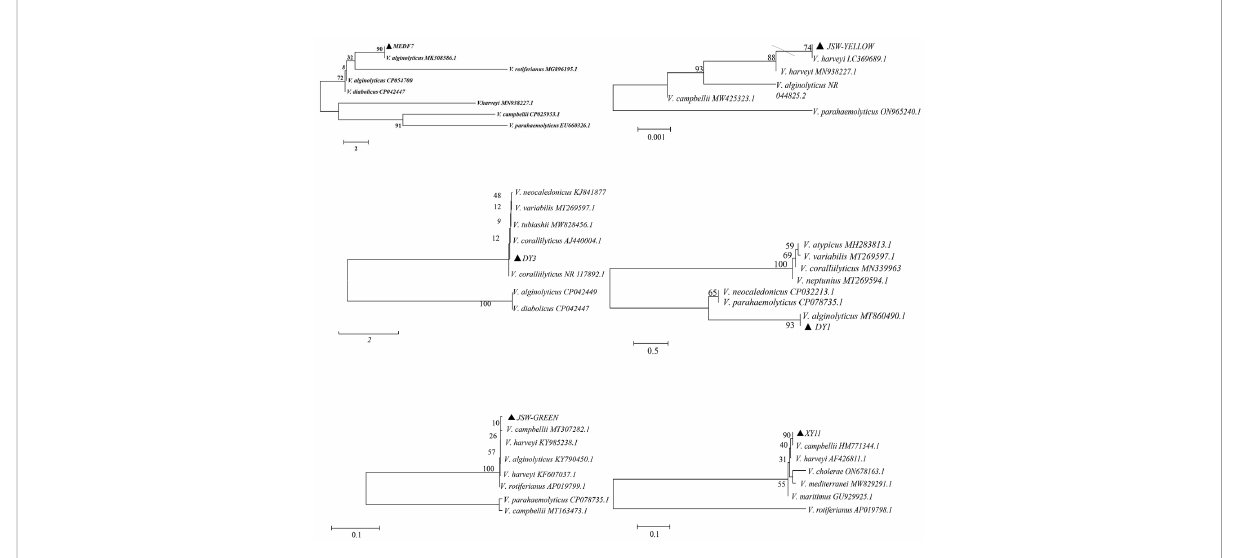
FIGURE 3 The 16S rRNA phylogenetic tree. Phylogenetic tree construction using MEGA6.0 and neighbor-Joining method (1000-fold